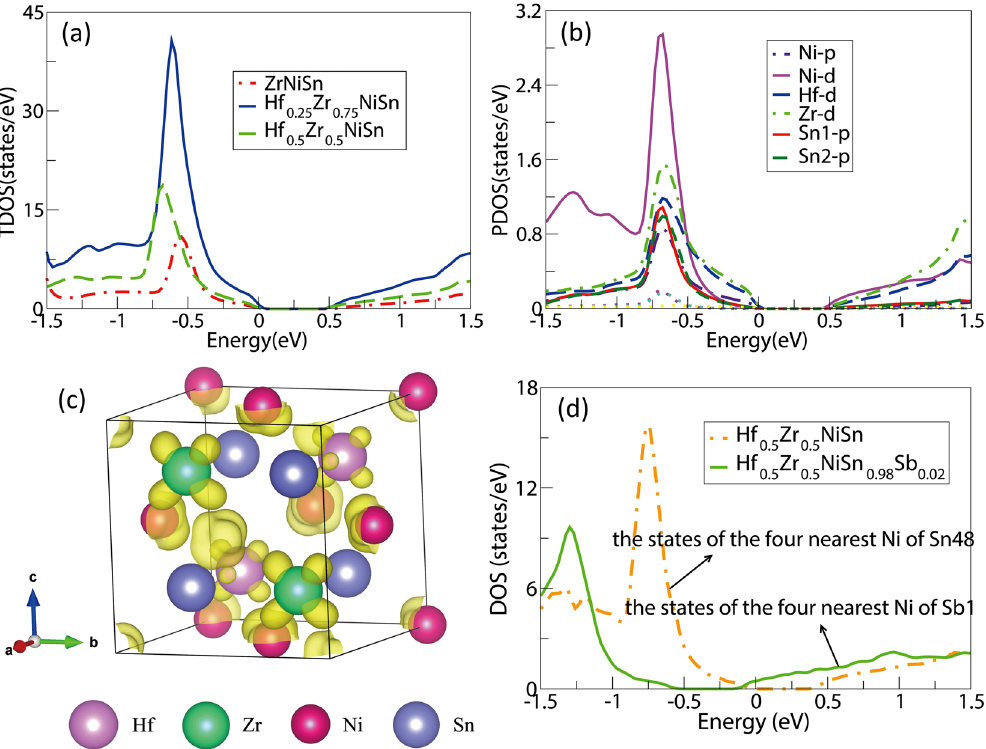
Figure 6. ( a ) Calculated the TDOS of ZrNiSn, Hf 0.25 Zr 0.75 NiSn and Hf 0.5 Zr 0.5 NiSn. ( b ) PDOS of Hf 0.5 Zr 0.5 NiSn. ( c ) The band decomposition charge density of Hf 0.5 Zr 0.5 NiSn at the bottom of CB with the isosurface value of 0.003 e/Å 3 . ( d ) The states of the four nearest Ni atoms of Sn48 and Sb1.